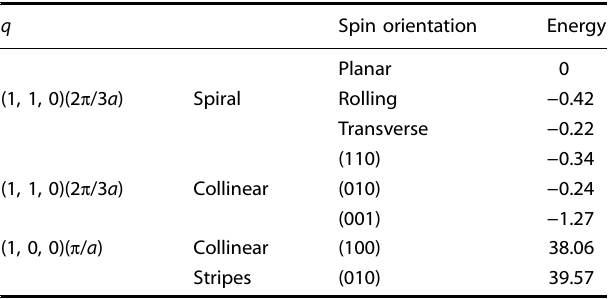
Table 1. Calculated total energies (meV/Ru) of various states with the q 3 ¼ ð 1 ; 1 ; 0 Þ 2 π 3 a